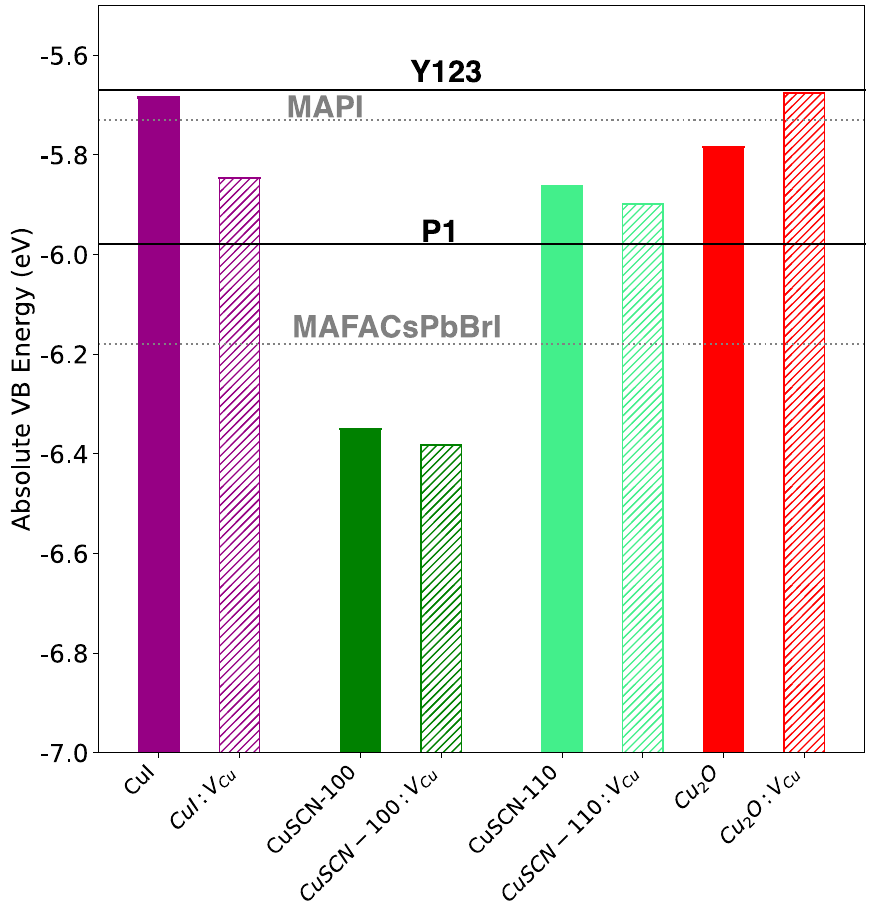
Figure 6. Absolute positions of the VB edges of pristine (fully colored rectangles) and Cu-defective (hatched rectangles) CuI, CuSCN and Cu 2 O slabs, in comparison to that of MAPI and triple cation MAFACsPbBrI perovskites (dotted gray lines) and the P1 and Y123 dyes’ HOMO (solid black lines).